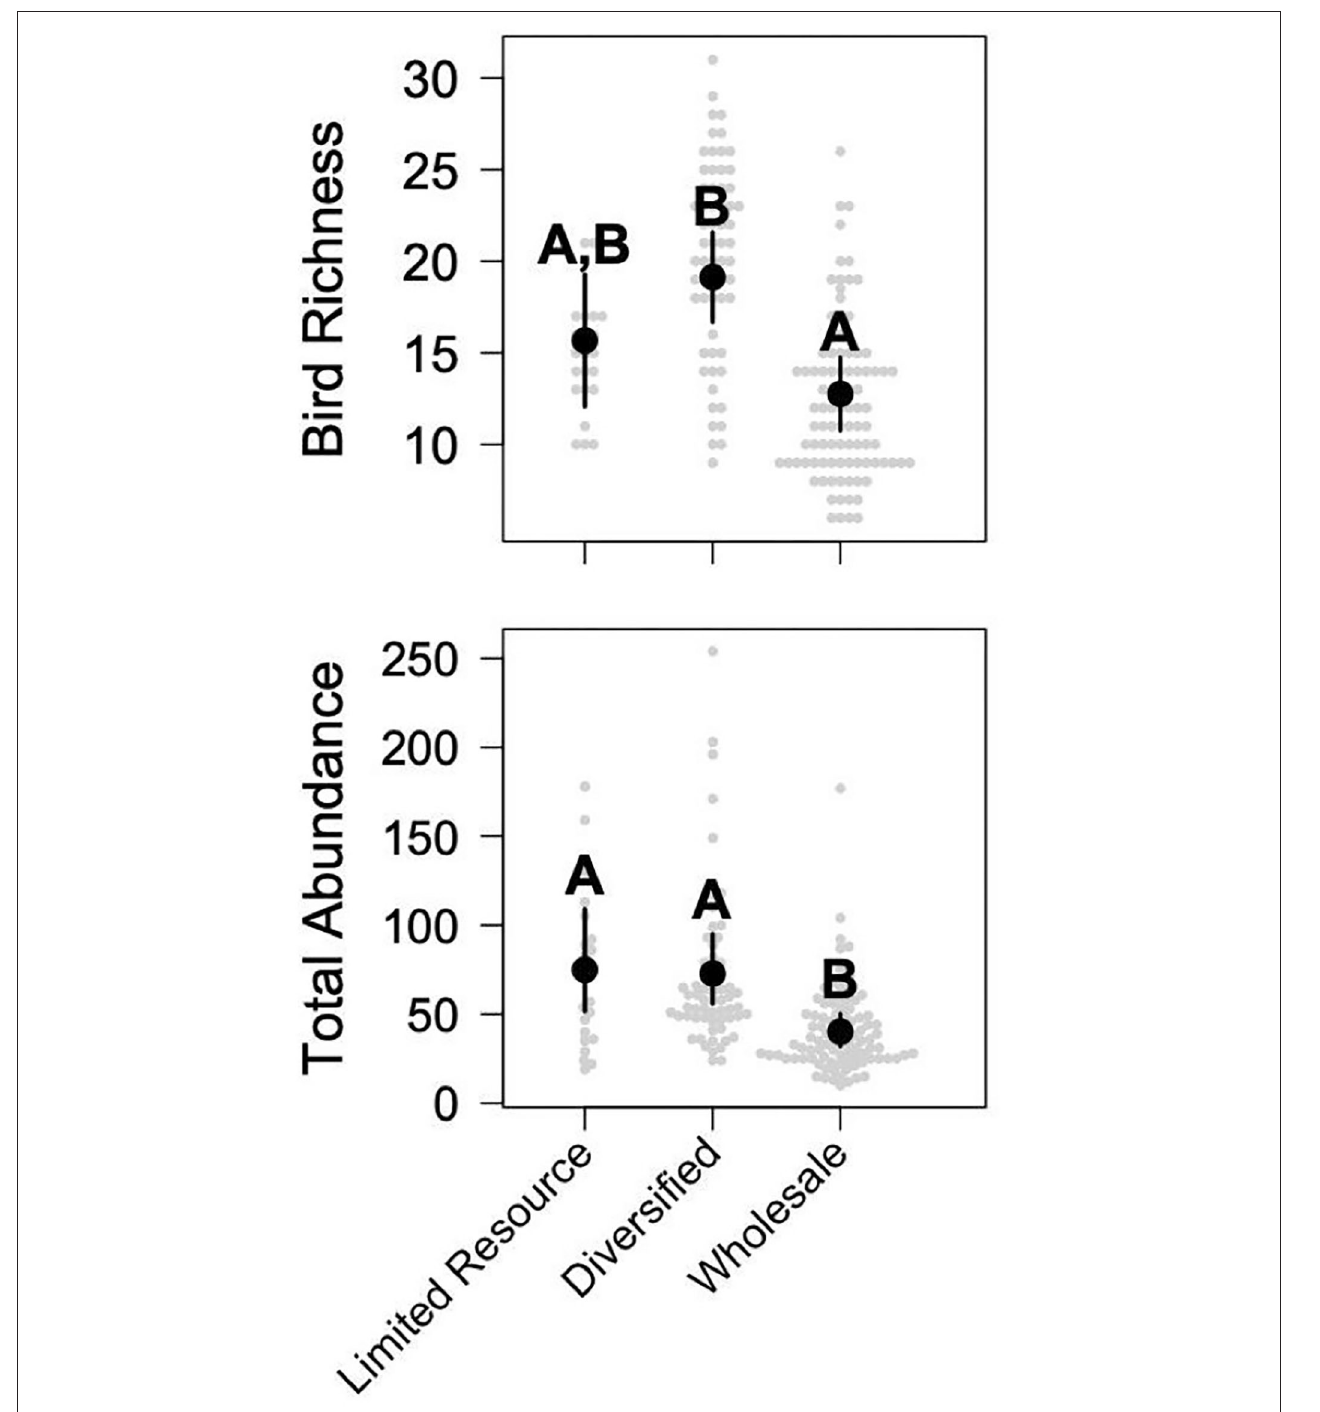
FIGURE 3 | Effects of farm types on bird communities. Bird species richness and abundance were significantly higher on diversified than wholesale farms. Bird communities on limited resource farms had intermediate levels of diversified but high abundances, equivalent to diversified farms and significantly higher than whole farms. Gray points indicate richness (top panel) and total abundance (bottom panel) estimates at all point-count locations from N-mixture models. Solid black points and lines indicate estimates and 95% confidence intervals from linear mixed models; letters denote significance under Tukey posthoc tests.